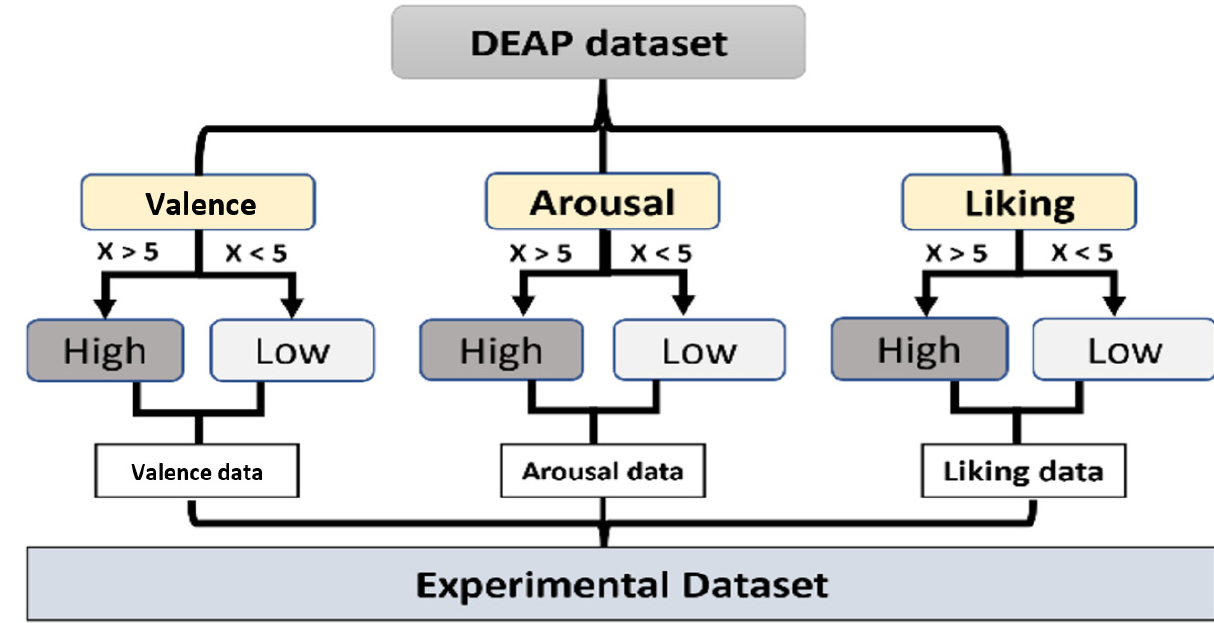
Figure 10. Structures of the categorized dataset.